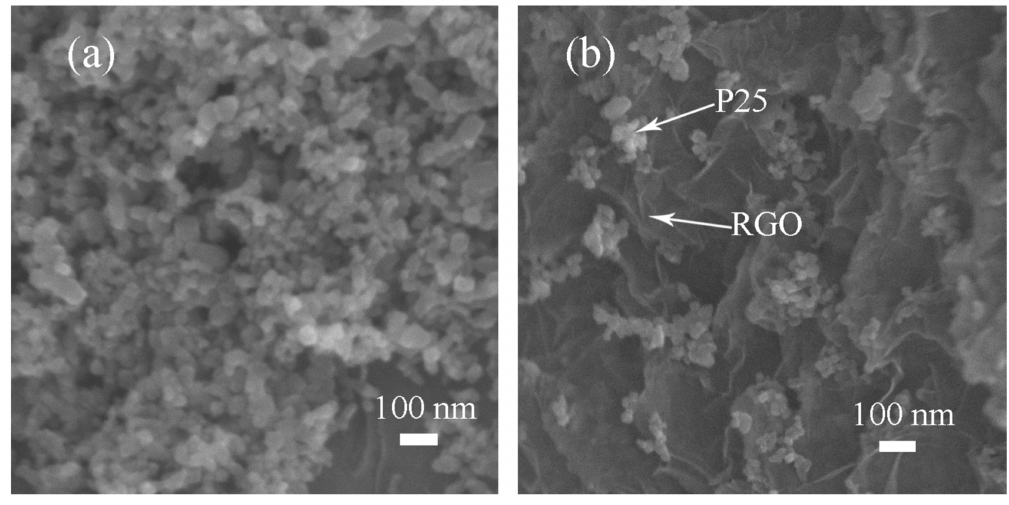
Figure 4. SEM images of P25 ( a ) and RGO-P25 ( b ).